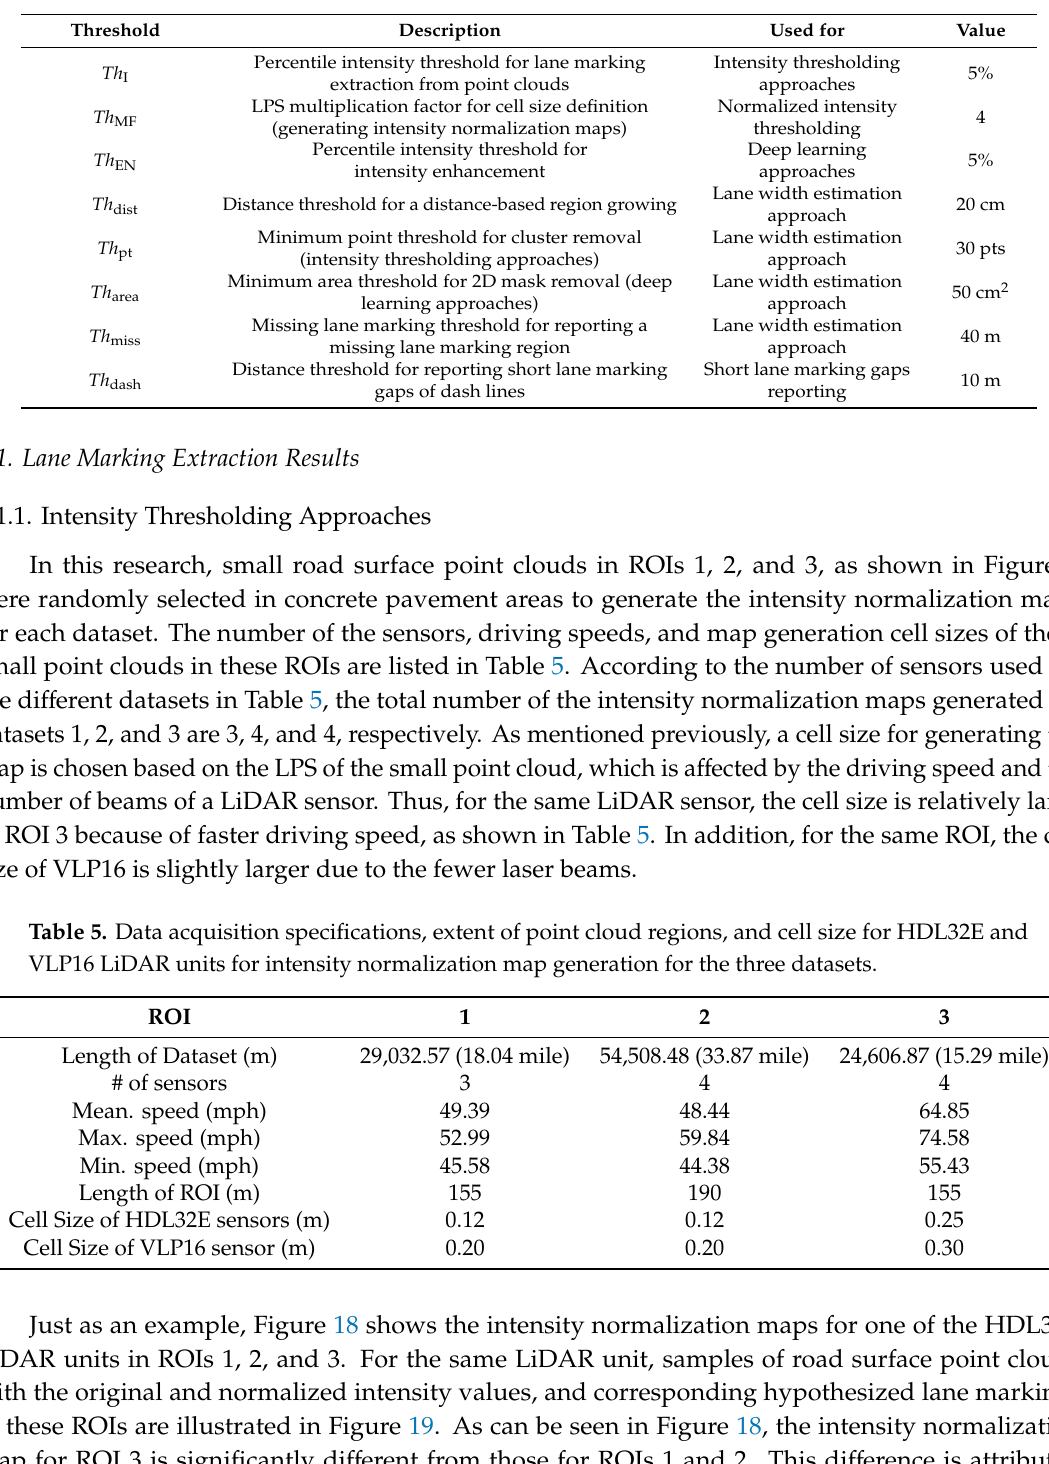
Table 4. Thresholds used for lane marking extraction and lane width derivation.